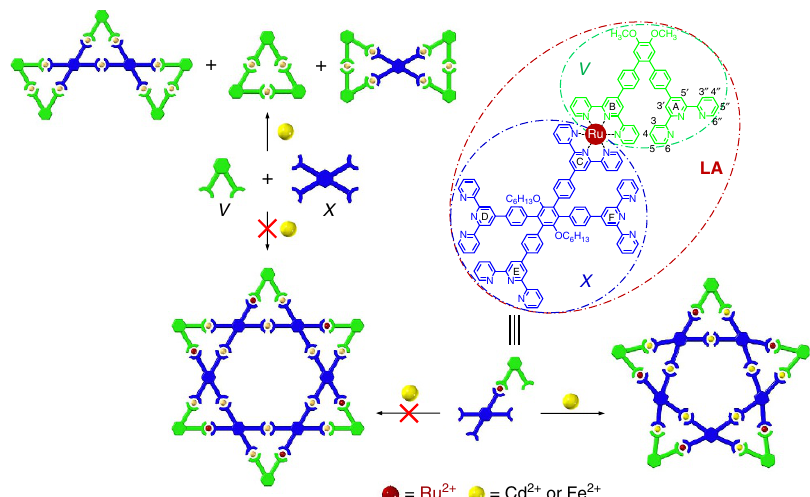
Figure 2 | Illustration of an initial molecular hexagram designation. Self-assembly of unexpected pentagram and multiple triangular assemblies in the initial design of hexagram.